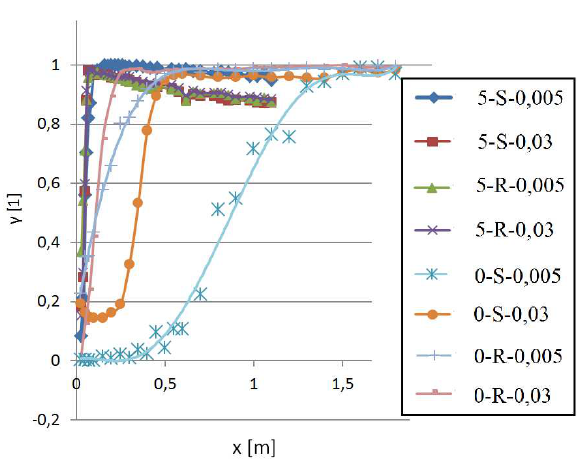
g * describes boundary